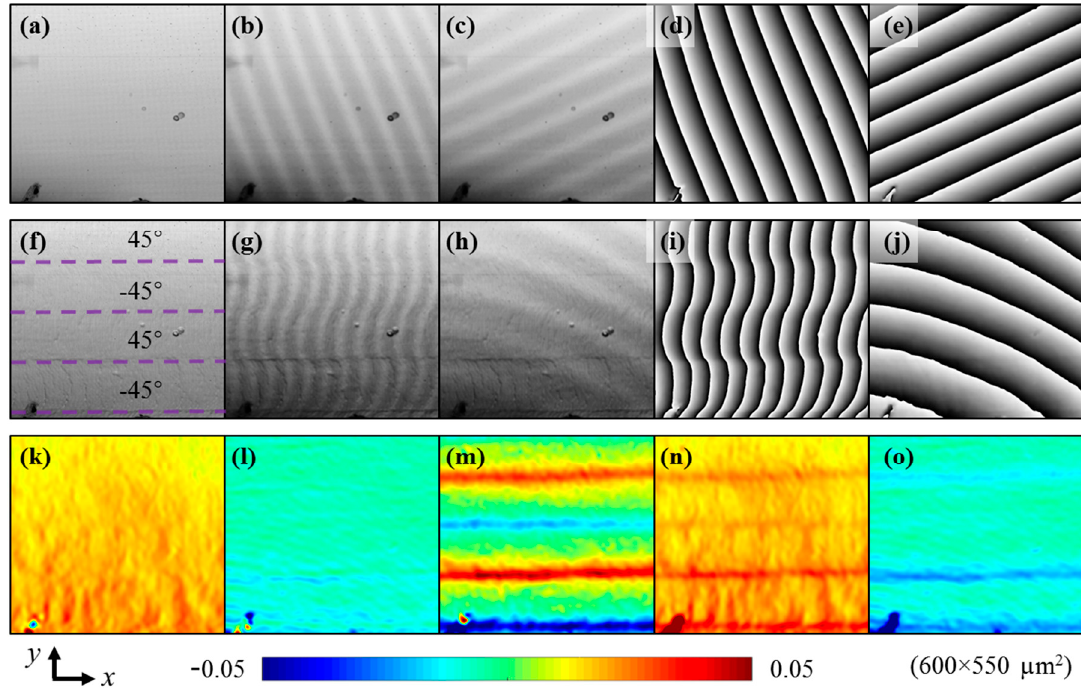
Figure 7. Strain measurement process and results: Images of ( a ) grid, ( b ) Moir é x , ( c ) Moir é y , ( d ) Moir é phase x and ( e ) Moir é phase y at 0MPa; Images of ( f ) grid, ( g ) Moir é x , ( h ) Moir é y , ( i ) Moir é phase x and ( j ) Moir é phase y at 258 MPa; distributions of ( k ) strain x , ( l ) strain y , ( m ) shear strain, ( n ) maximum principal strain and ( o ) minimum principal strain of CFRP. The phase range is − π – π ,